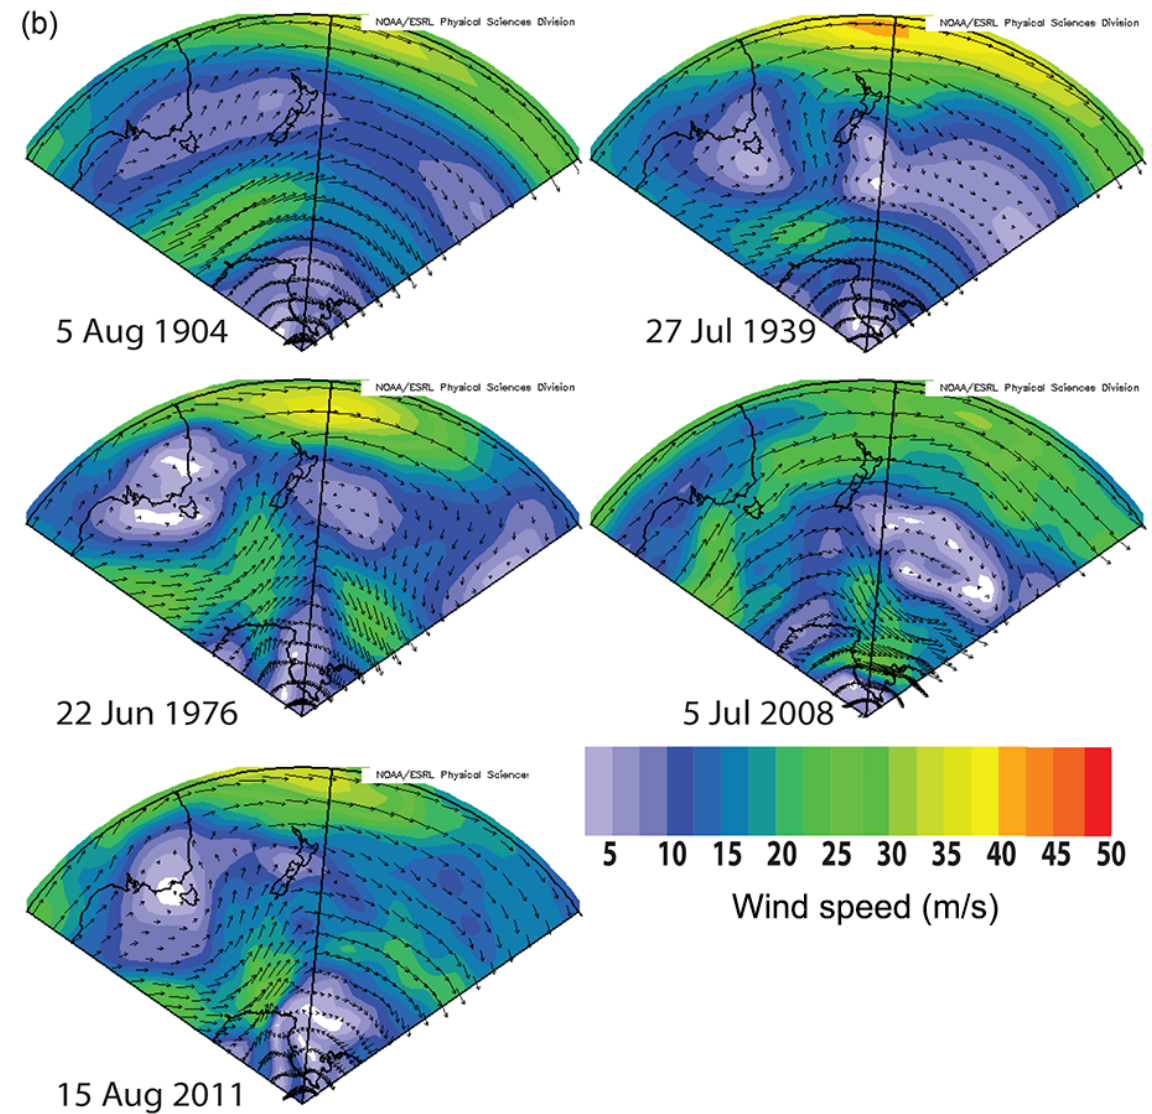
Figure 7. (a) (top) Distribution of historic frozen precipitation events (snowfall, sleet and graupel) for northern New Zealand and (bottom) reported elevations for the eyewitness accounts above plotted by latitude, with demarcation lines separating the minimum estimated settling elevation for frozen precipitation for each event. The diamond colours note evidence for distinct events: red – 2008; green – 1976; orange – 1868 and 1904; grey – 2011; blue – 1939. The maroon (encircled) diamond indicates the 30–31 July 1839 event recorded by Reverend Davis for the Putahi volcanic cone when he was living at Waimate North. (b) 500hPa wind strength and streamlines for the aforementioned snowfall events, courtesy of the 20th Century Reanalysis